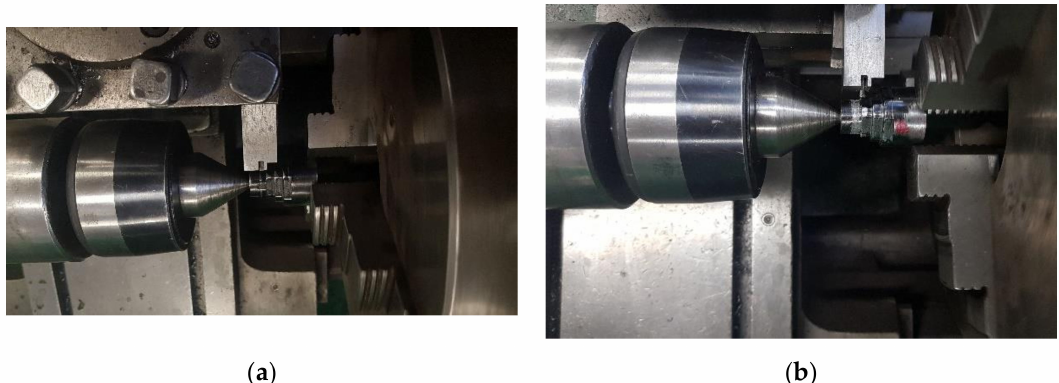
Figure 8. The research stand for determining the wear in contact zone between the plunger fin and the cylindrical surface of the shaft shoulder. ( a ) For the shaft shoulder with the lowest diameter equal to 17.5 mm and two cuts A; ( b ) for the shaft shoulder with the diameter equal to 20 and four cuts B. Watrin et al. [94] proposed a related Equation (15) between the wear coefficient k A and the sliding distance L w